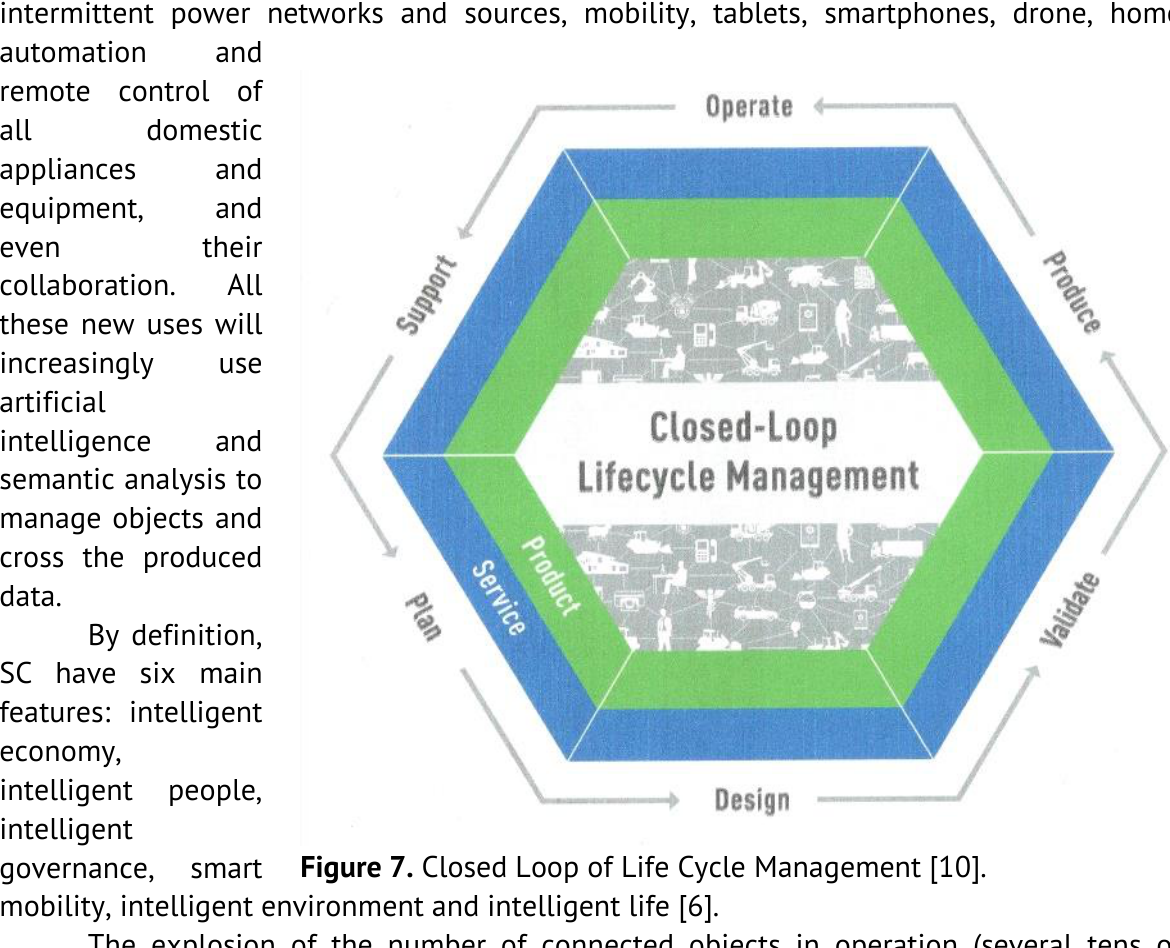
Figure 7. Closed Loop of Life Cycle Management